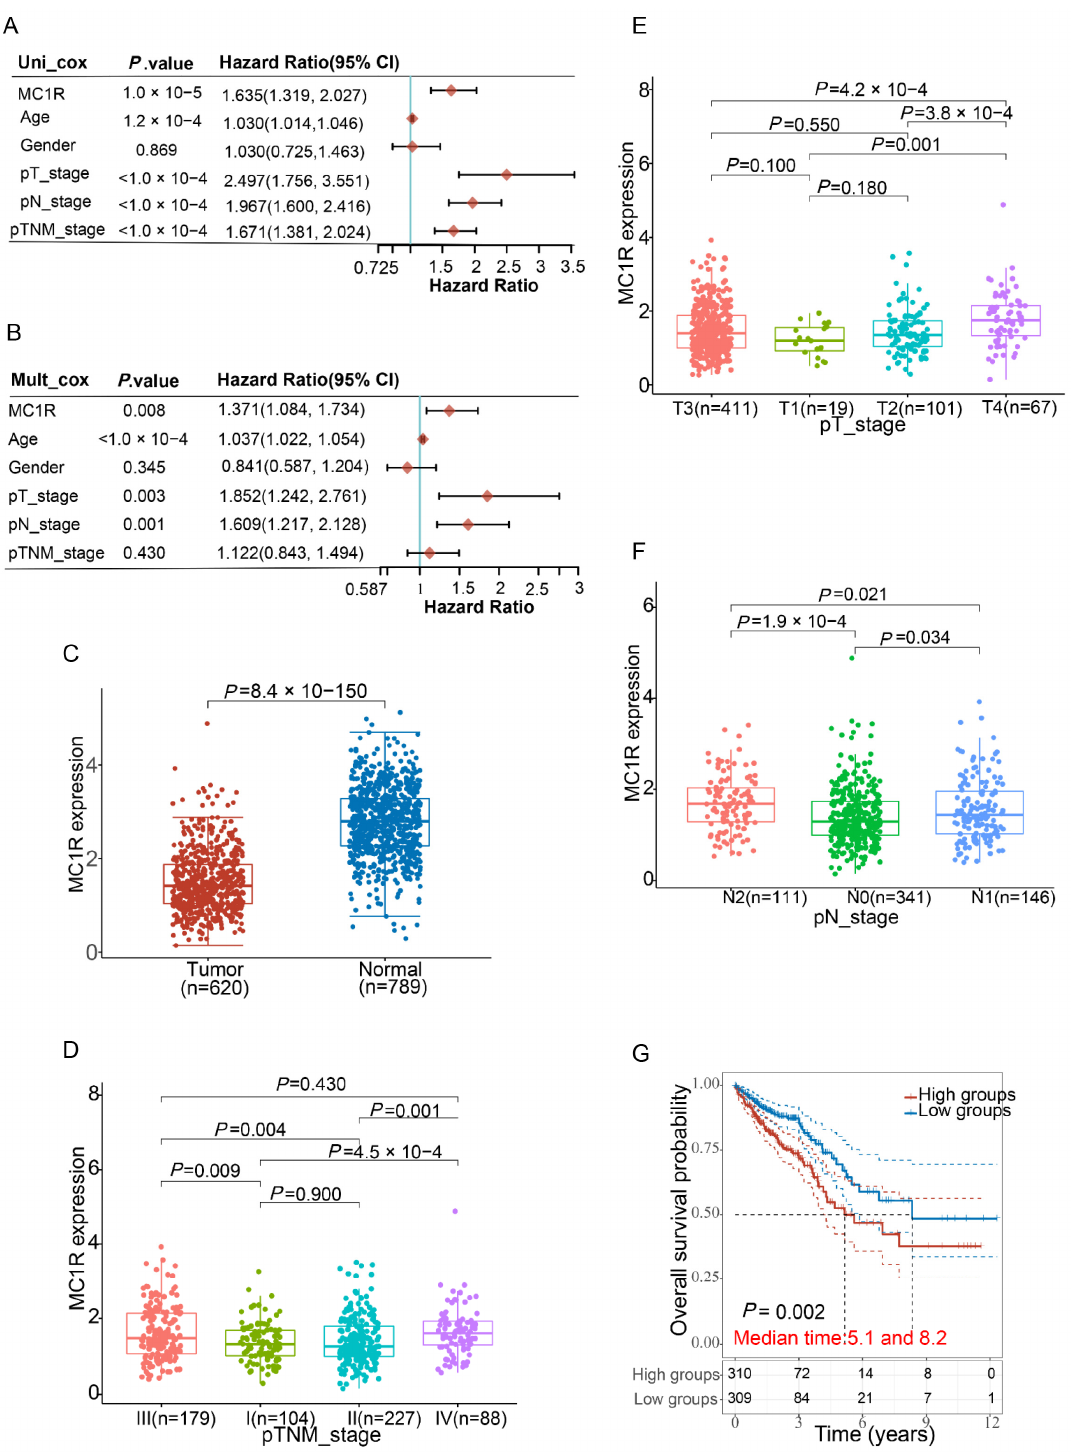
Figure 2. Prediction of the prognostic significance of MC1R in CRC and differential expression of MC1R in CRC. ( A ) and ( B ) Hazard ratio and P value of constituents involved in univariate and multivariate Cox regression and some features of the MC1R genes. ( C ) The expression of MC1R in colorectal cancer is significantly lower than that in normal tissue. Correlation between MC1R expression and clinicopathological features of CRC, including ( D ) T stage, ( E ) N stage, and ( F ) TNM stage. ( G ) Kaplan–Meier curves show overall survival among patients with CRC stratified by MC1R expression. RNA-sequencing data comprising 620 CRC patients obtained from TCGA, 10 colorec- tal normal tissue samples obtained from TCGA, and 779 normal tissue samples